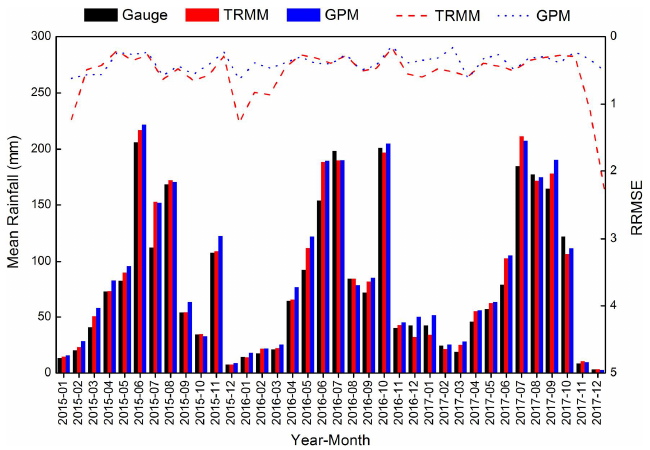
Figure 4. Time series of RRMSE (dot/dash line) and mean monthly precipitation (bar graph) from 2015 to 2017 over the Huaihe River basin.